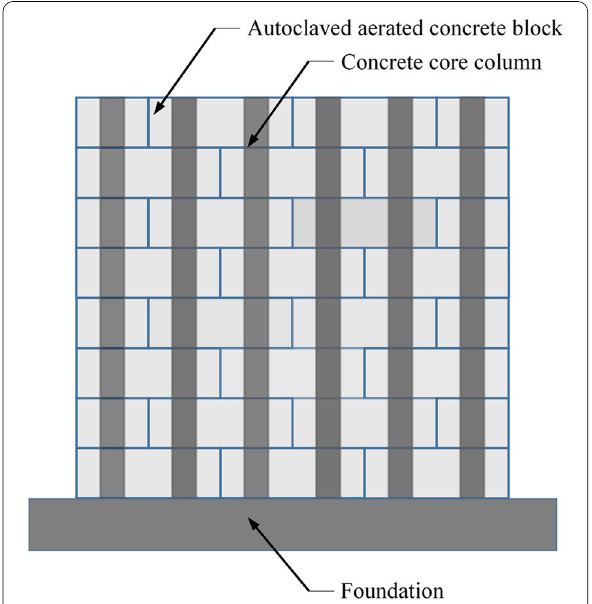
Fig. 2 The wall built in new type of AAC